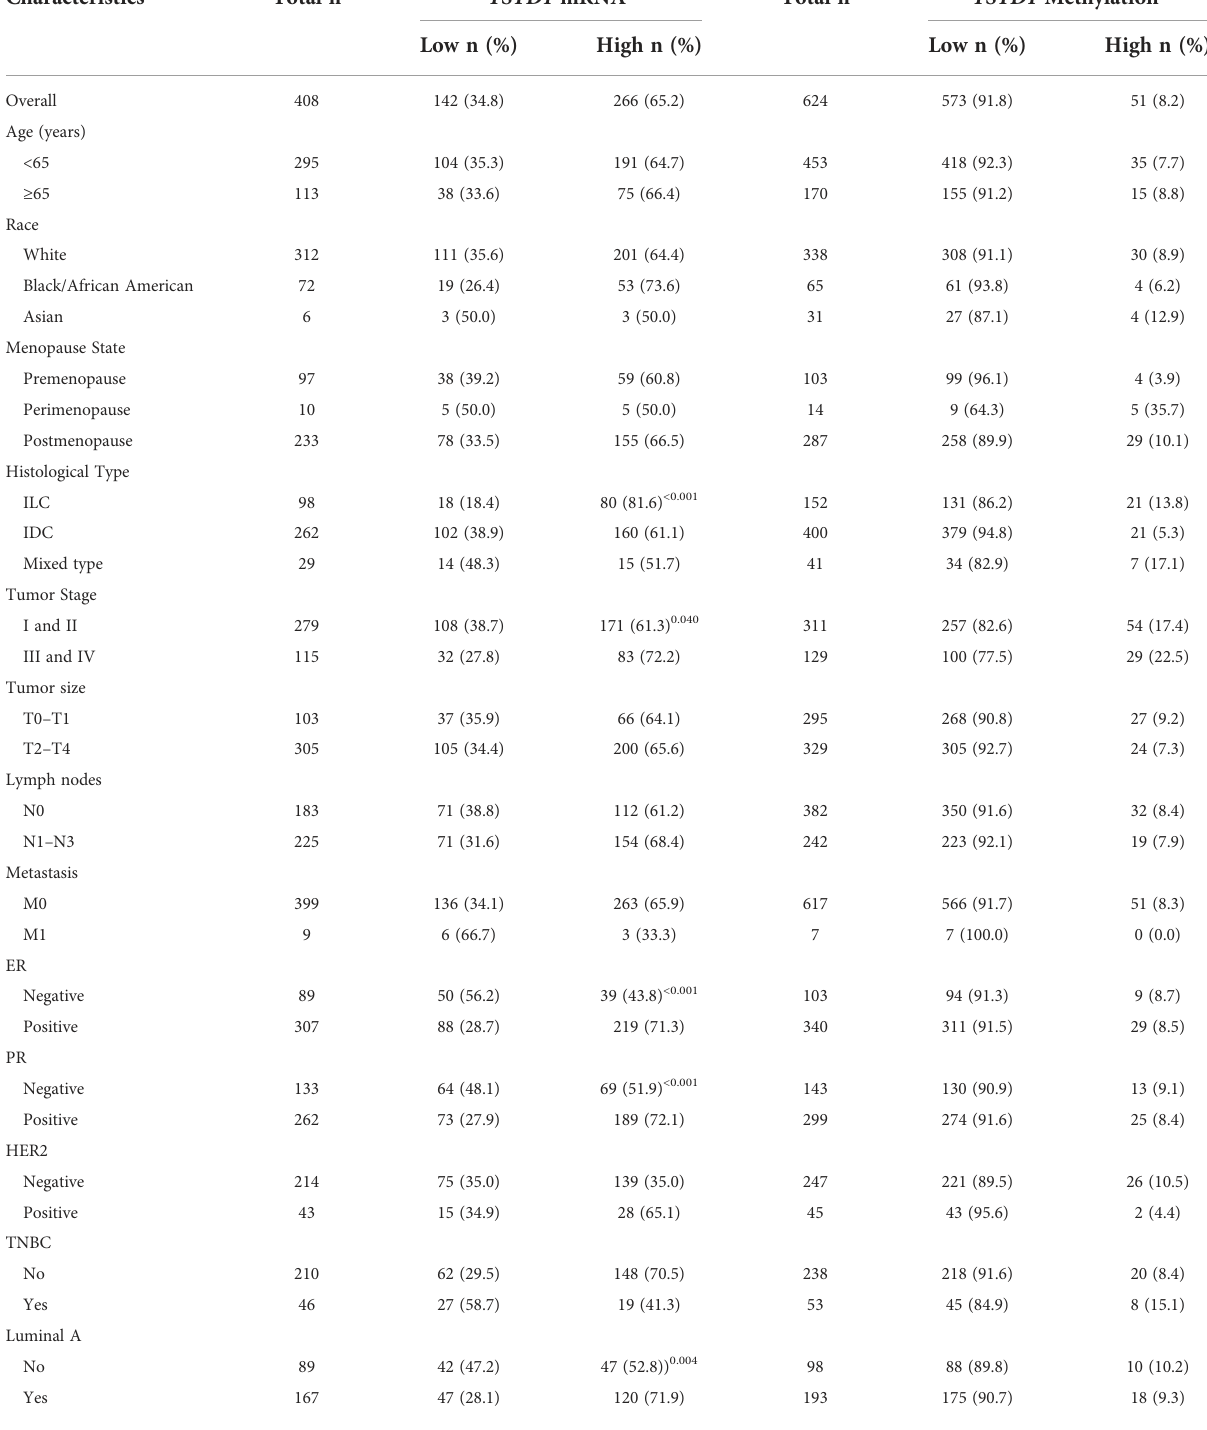
TABLE 2 TSTD1 mRNA expression and methylation levels in relation to the clinical parameters of Western with breast cancer.